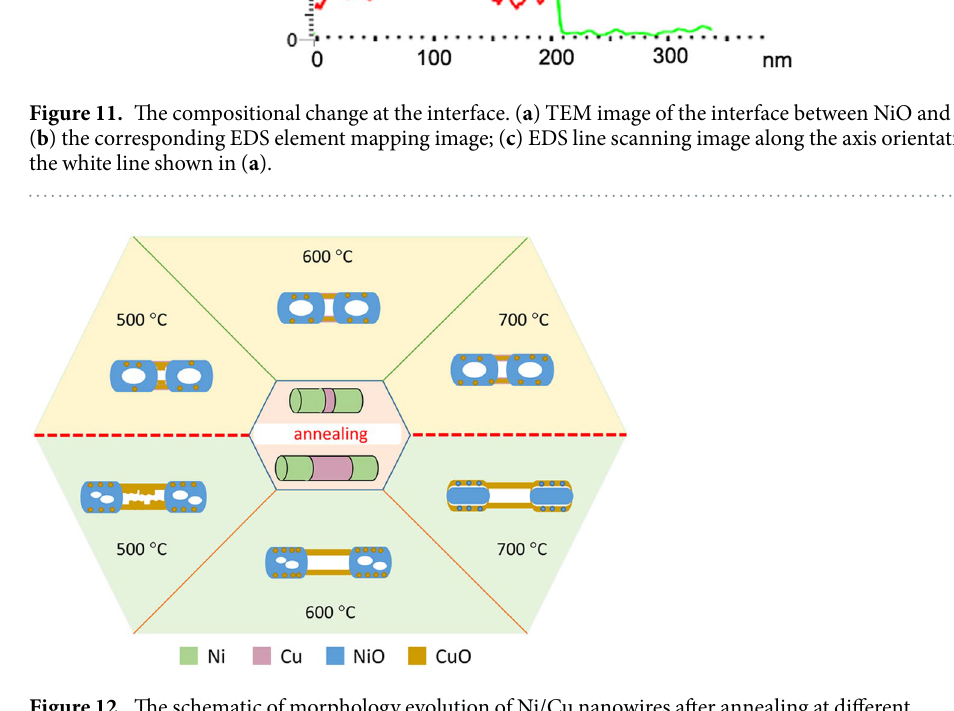
Figure 12. The schematic of morphology evolution of Ni/Cu nanowires after annealing at different